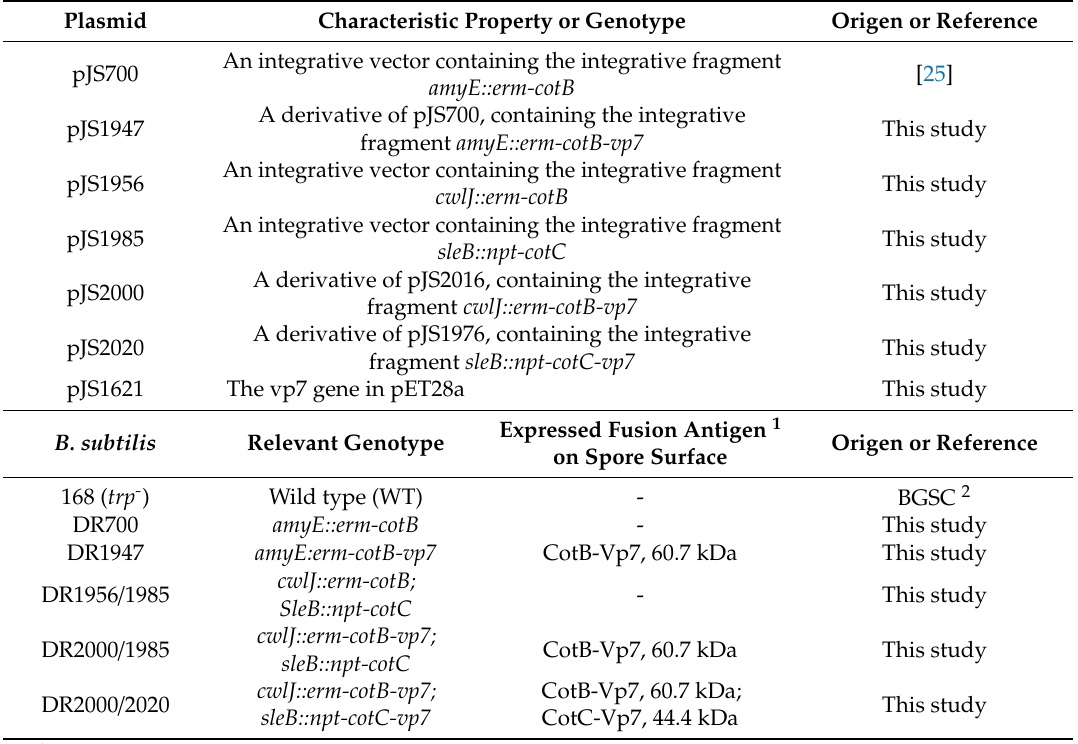
Table 1. Plasmids and strains used in this